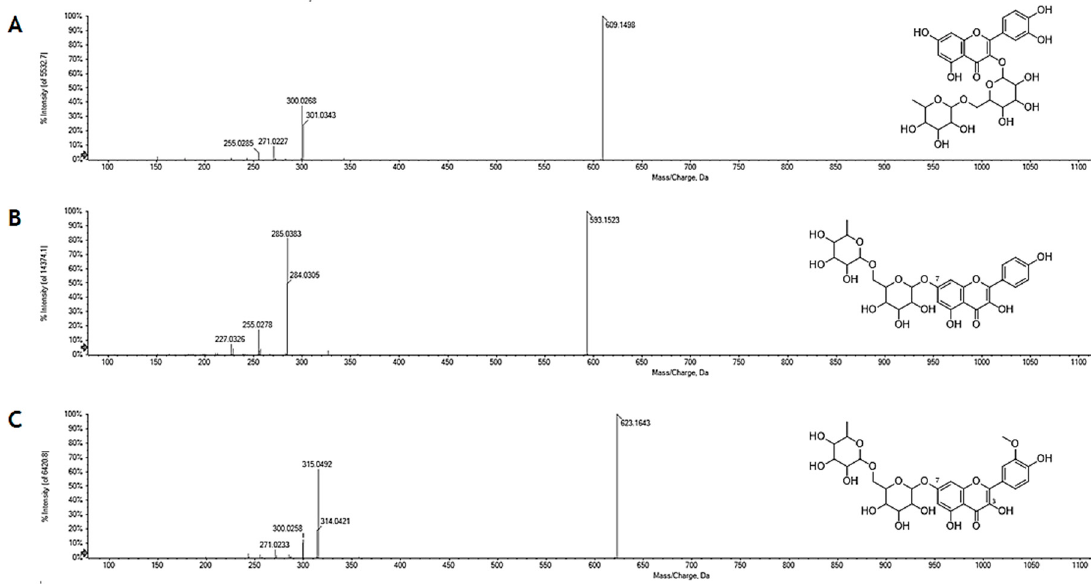
Figure 2. Flavonol rutinosyl derivatives; TOF-MS 2 spectrum of metabolites ( A ) 12 ; ( B ) 15 ; and ( C ) 17.